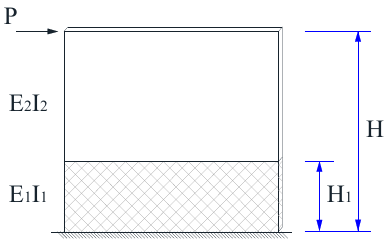
Figure 2. Calculation diagram of displacement.